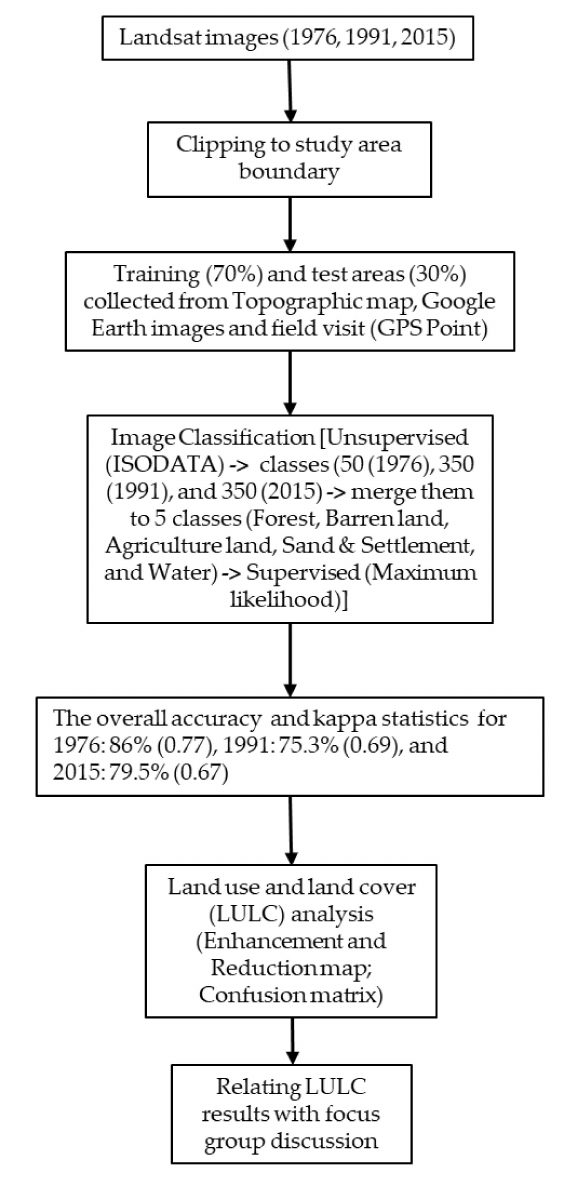
Figure 3. Flow chart for methodology of land use and land cover (LULC)